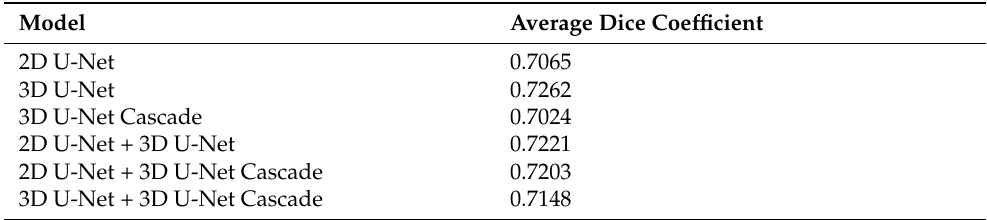
Table 3. Model performance measured by the average Dice coefficient during cross-validation. The model with the highest dice score is